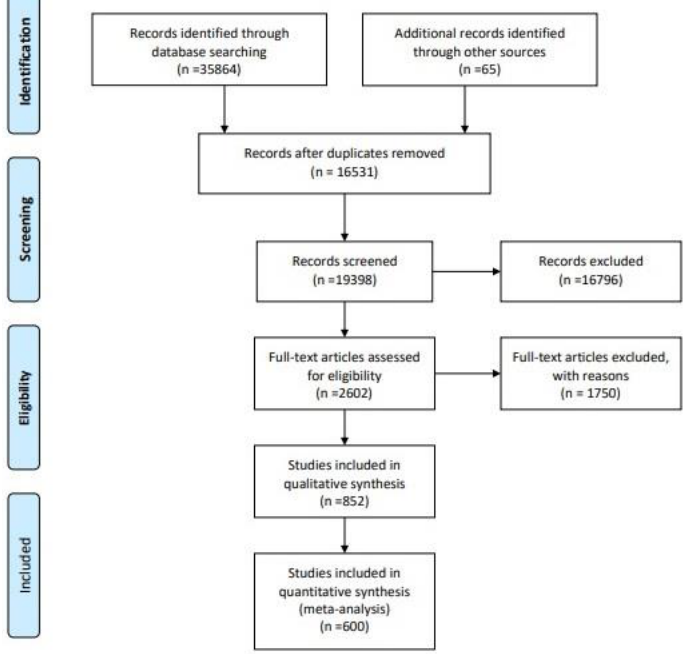
Figure 1. Search strategy and article selection process according to the Preferred Reporting Items for Systematic Reviews and Meta-Analyses (PRISMA) guidelines [14].